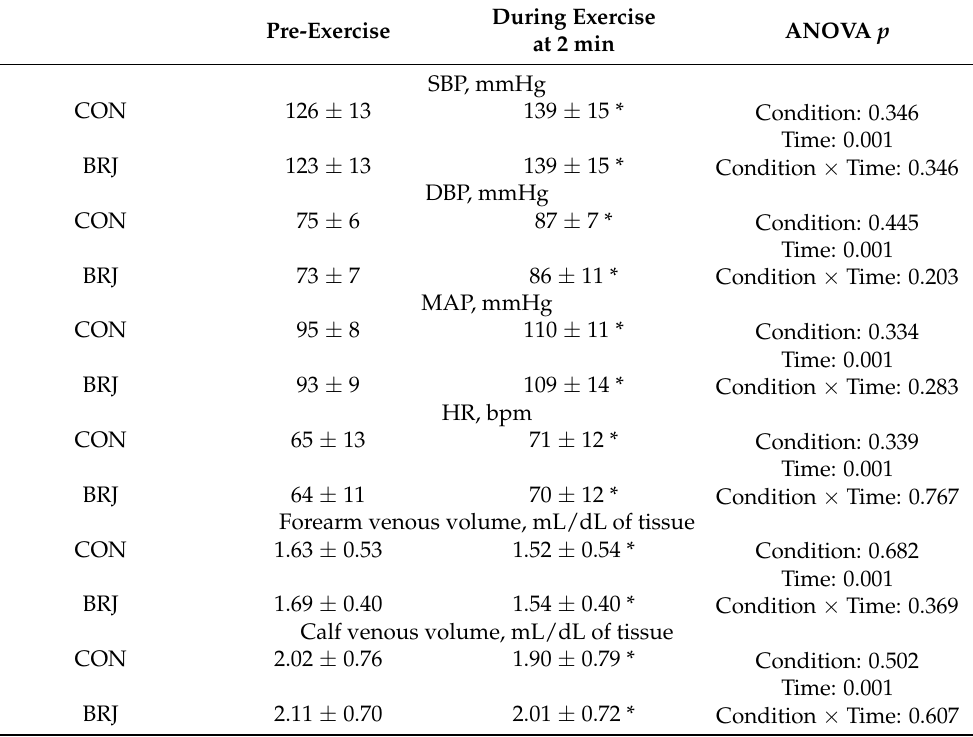
2 min. Data are expressed as values for n = 16 (10 men, 6